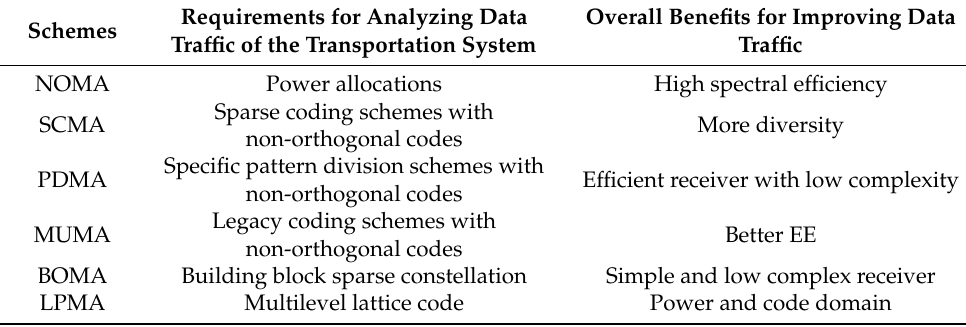
Table 1. Benefits of 5G-based multiple accessing